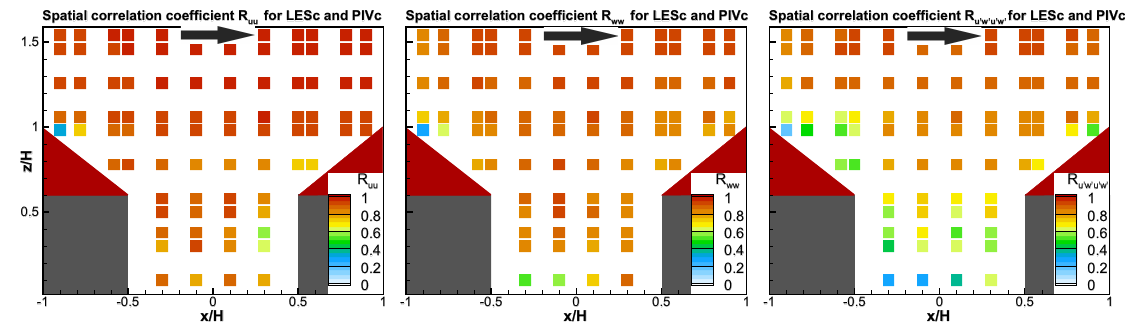
Figure 11. The final correlation coefficients between the PIVc and the LESc spatial correlation fields of the streamwise velocity R uu (first column), of the vertical velocity R ww (second column) and of the momentum flux R u (cid:48) w (cid:48) u (cid:48) w (cid:48) (third column). Each point shows the comparison based on the spatial correlation of the correlation coefficient fields between PIVc and LESc at one of the 132 shared points of the PIV and LES